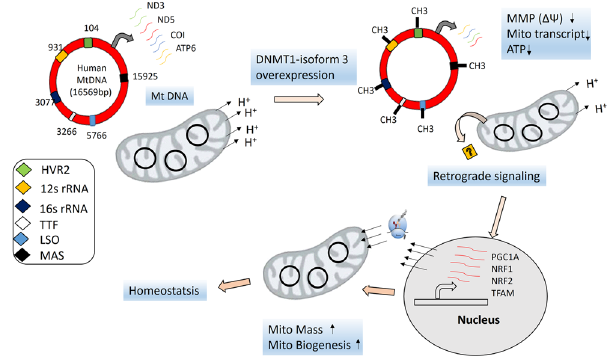
Figure 7. The proposed model depicting DNMT1-isoform3 function in mitochondrial biology. DNMT1 isoform3 methylates mitochondrial DNA and causes mitochondrial dysfunction, evident from a decrease in MMP, mitochondrial transcripts (ND3 ND6, COI, ATP6) and ATP levels. The acute mitochondrial dysfunction is communicated to nucleus through retrograde signaling, which results in upregulation of mitochondrial biogenesis genes (PGC1A, NRF1, NRF2, TFAM, TFB2M) and an increase in mitochondrial mass to maintain the homeostatsis. The six diagonals with different color codes represents the CpG sites (TTF: transcription termination factor at 3266, LSO: L-stand origin of replication at 5766, MAS: membrane attachment site at 15925, HVR2: hypervariable region2, 12s rRNA at 104, 16s rRNA at 3077 positions in mtDNA) located within the important regulatory regions involved in mitochondrial transcription and